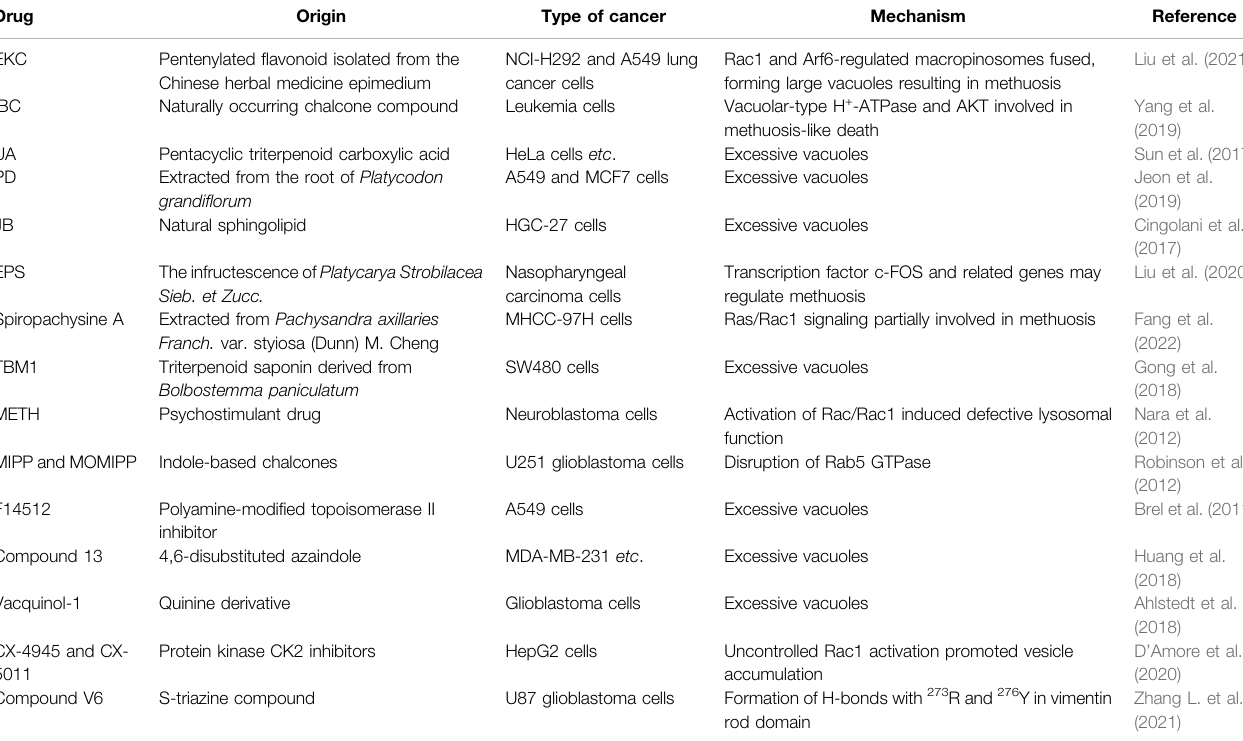
TABLE 2 | Methuosis-inducing